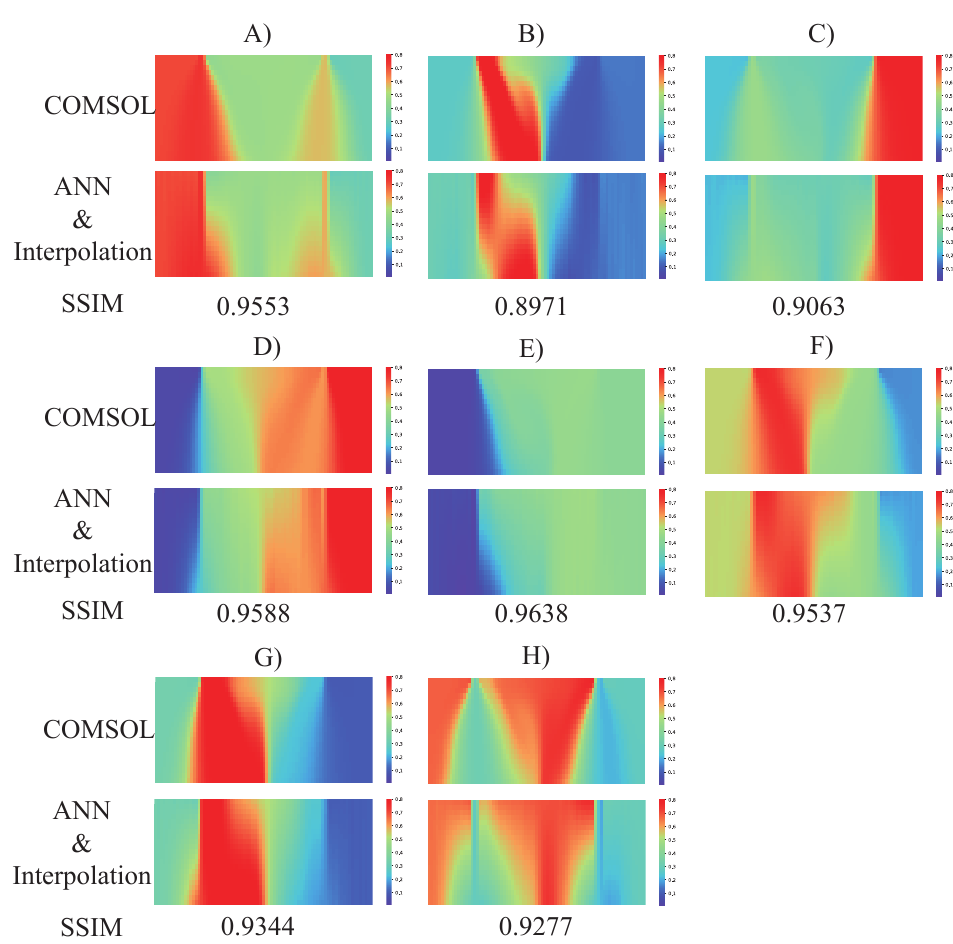
Figure 8. The concentration profile of the reactive region predicted by COMSOL and proposed ANN and interpolation method. The corresponding SSIM values are listed for quantification analysis as well between two methods. The SSIM values of design ( A – H ) are 0.9553, 0.8971, 0.9063, 0.9588, 0.9638, 0.9537, 0.9344, and 0.9277,